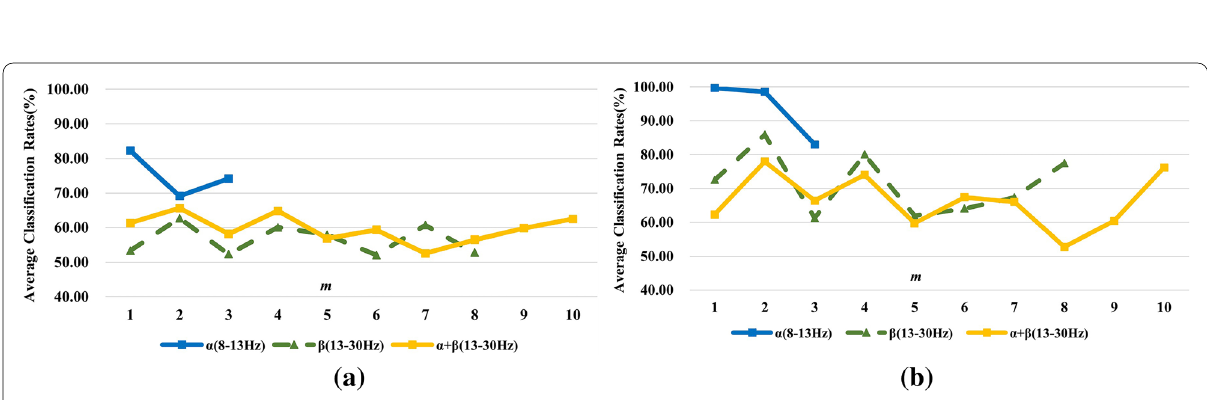
Fig. 6 Effects of different frequency bands and m values on the classification results for subject a ‘k6b’ and b